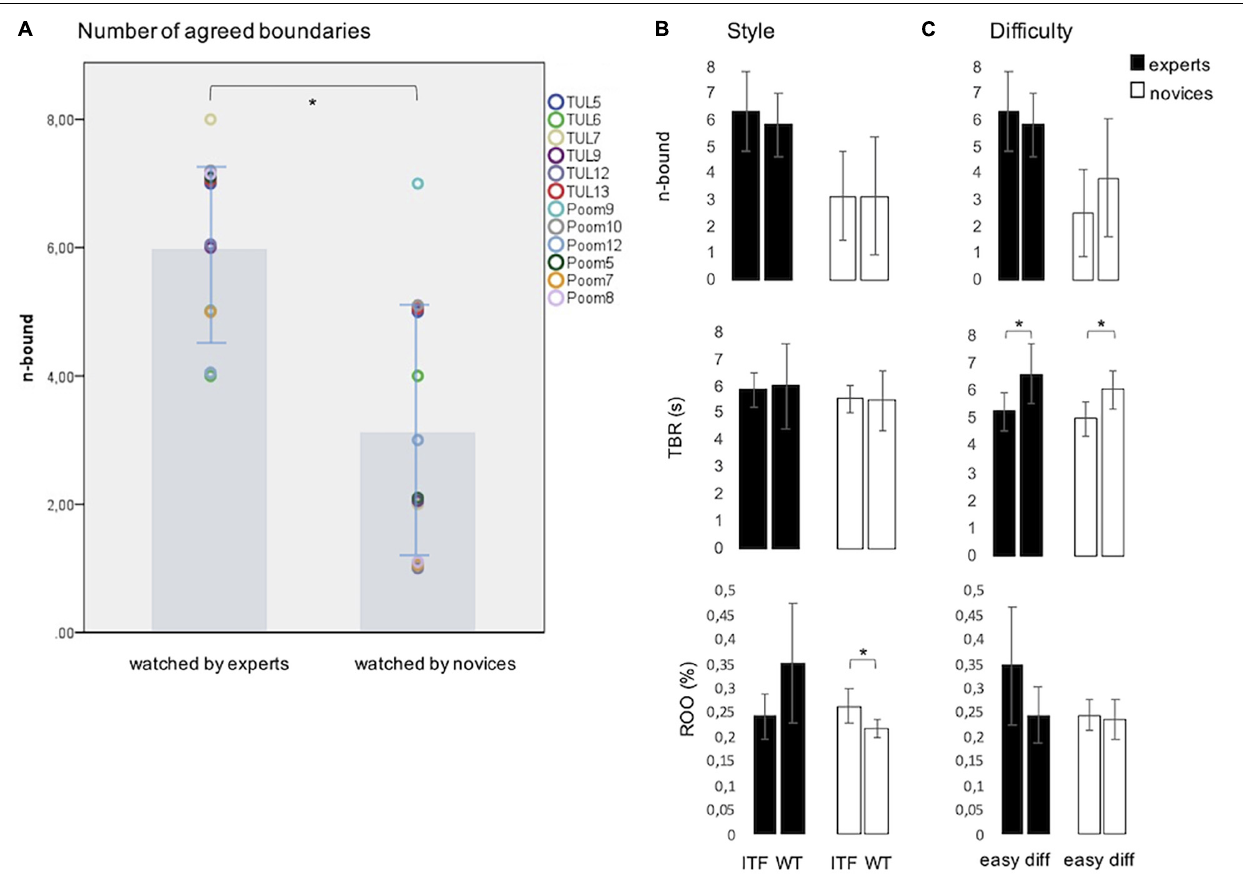
FIGURE 4 | (A) Experts agreed on a higher number of boundaries (n-bound) than novices. Colored points represent n-bound in each of the 12 single videos watched by experts and novices. (B) Style (ITF vs. WT) had no effect on n-bound and on average time between responses (TBR). In novices, response overlap was significantly higher in ITF than in WT actions. The high agreement in WT in experts was not significant. (C) The difficulty (in terms of complexity) of the action sequences only affected TBR significantly. In both groups more time passed between boundaries in difficult sequences, i.e., the grain size of segmentation increased. In all graphs, bars show mean and error bars SD. * p < 0.05.